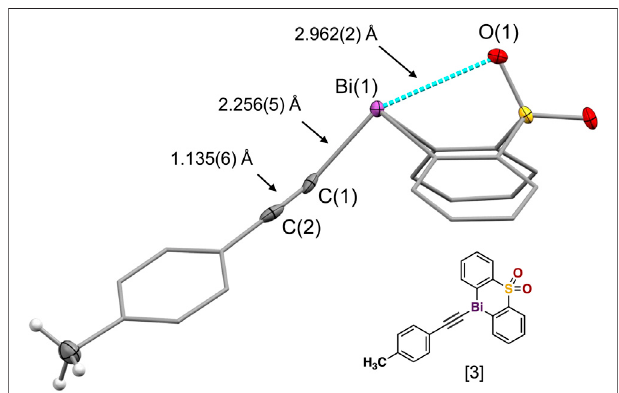
FIGURE 3 | Crystal structure of the bismuth(III) acetylide [3] with labeled Bi(1)-C(1), C(1) ≡ C(2) and C(2)-C(sp 2 ) bonds and transannular Bi(1)-O(1) interaction distances [Å].